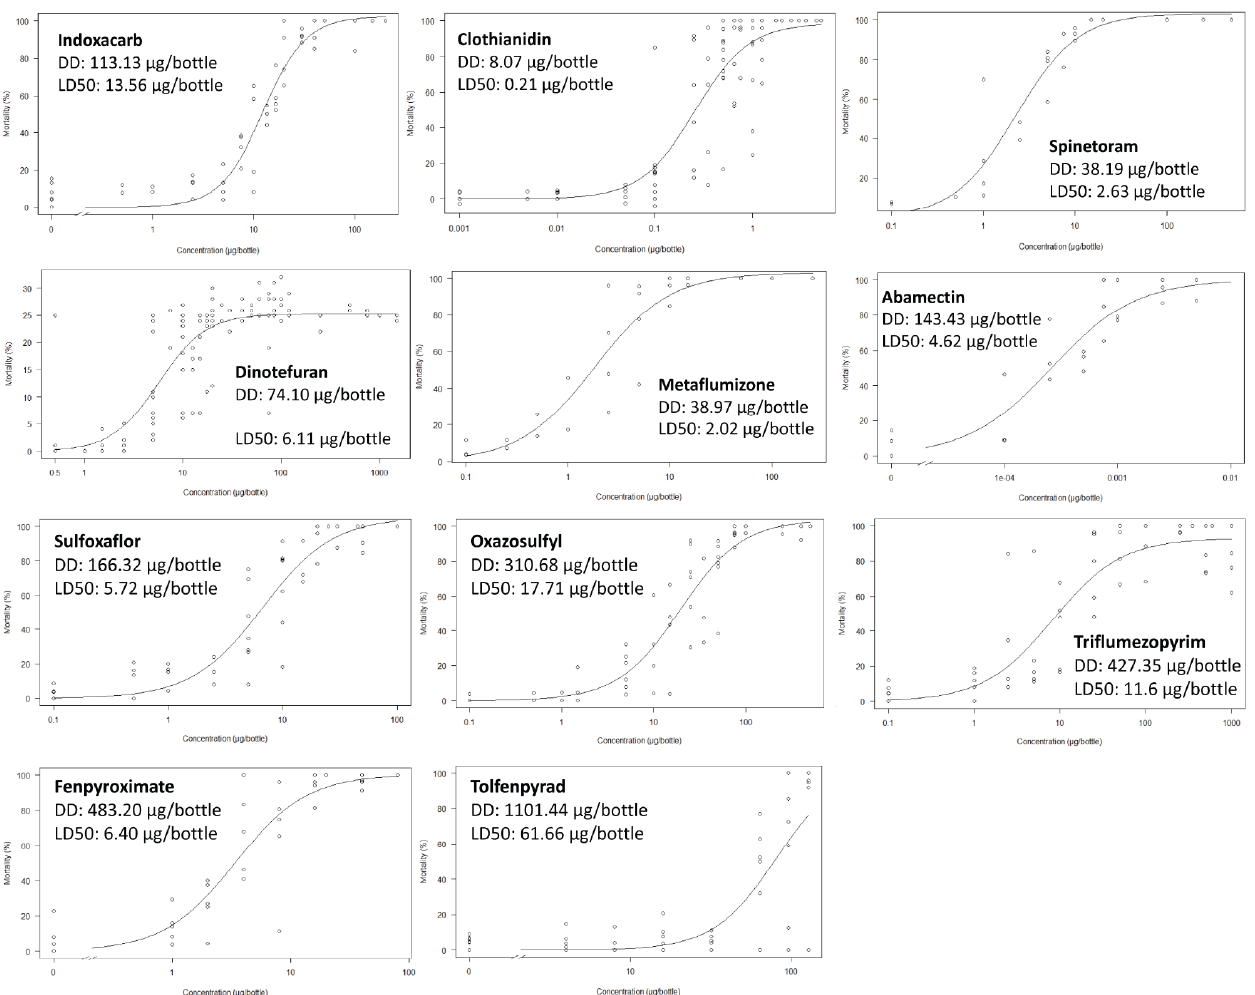
Figure 3. The 24-hour mortality dose response curves and discriminating doses of the 11 shortlisted compounds. Dose response curves were produced by measuring mortality of adult female Anopheles gambiae mosquitoes exposed to dried deposits of compounds applied in acetone to the inside of a bottle, in a version of the CDC bottle bioassay. Discriminating dose is calculated as the LC by